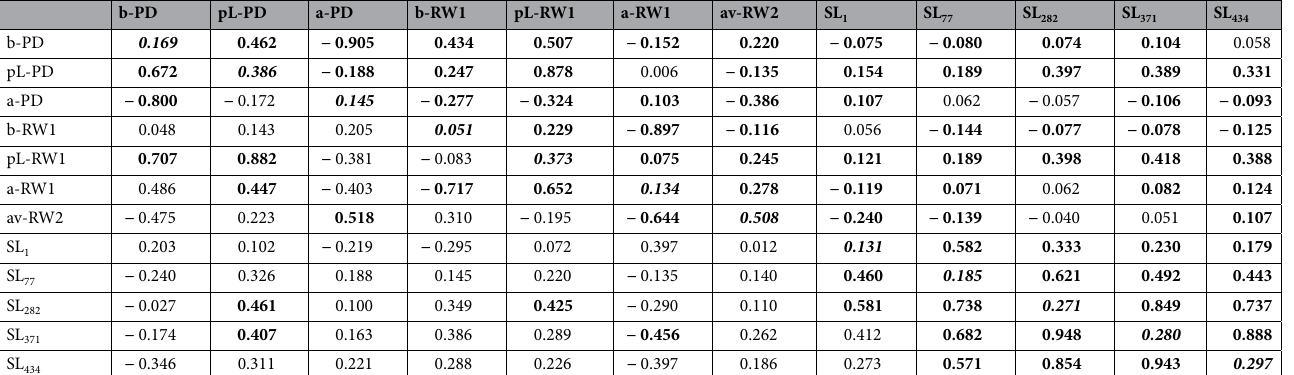
Table 2. Phenotypic (above diagonal) and genetic (under diagonal) correlations among traits of body- shape trajectory traits (RW1, PD and RW2) and fish standard length (SL). Diagonal values (italics) are the estimates of heritabilities of the traits under the multivariate model. Values in bold indicate statistically significant estimates ( P < 0.05). b-PD slope of Procrustes distances, pL-PD plateau of Procrustes distances, a-PD Y-intercept of Procrustes distances, b-RW1 slope of the first relative warp, pL-RW1 plateau of the first relative warp, a-RW1 Y-intercept of the first relative warp, av-RW2 mean value of the second relative warp between all age samples, SLi Standard length of fish for each